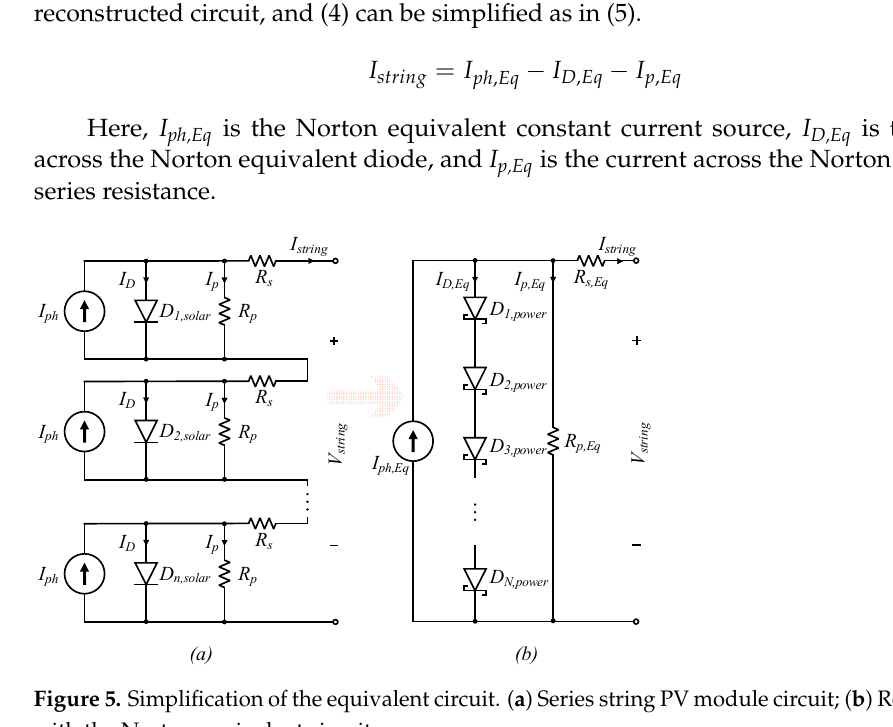
structed with the Norton equivalent circuit. with the Norton equivalent